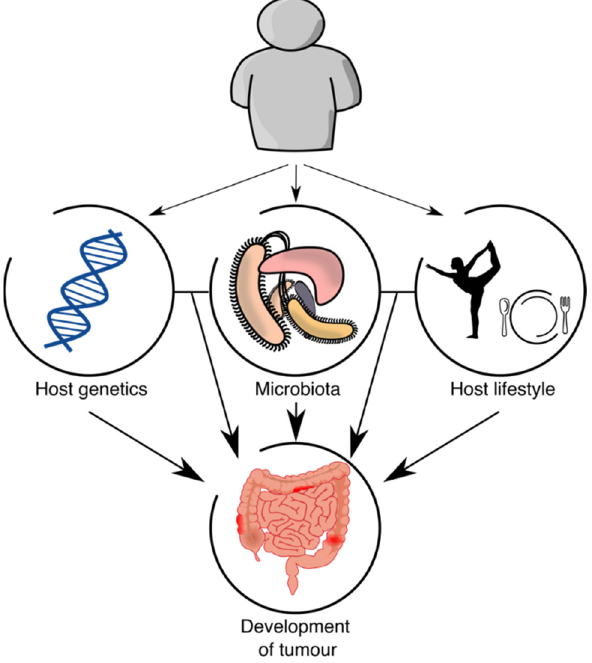
Figure 1. Host–microbiota interactions.